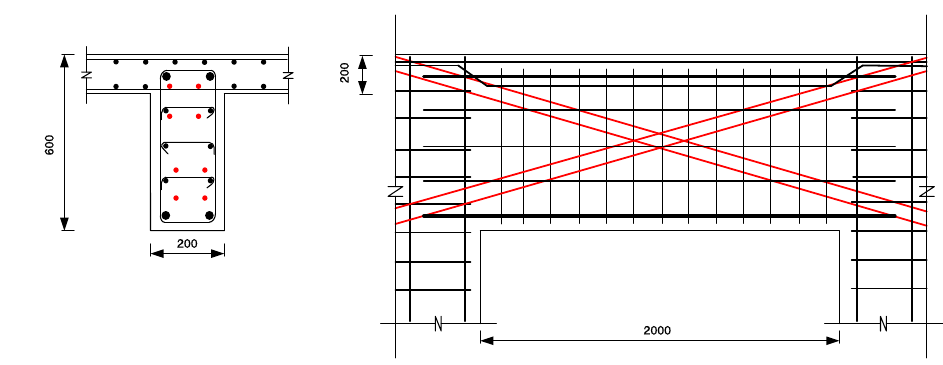
Fig. 3 X-shape rebars in the connecting beams.